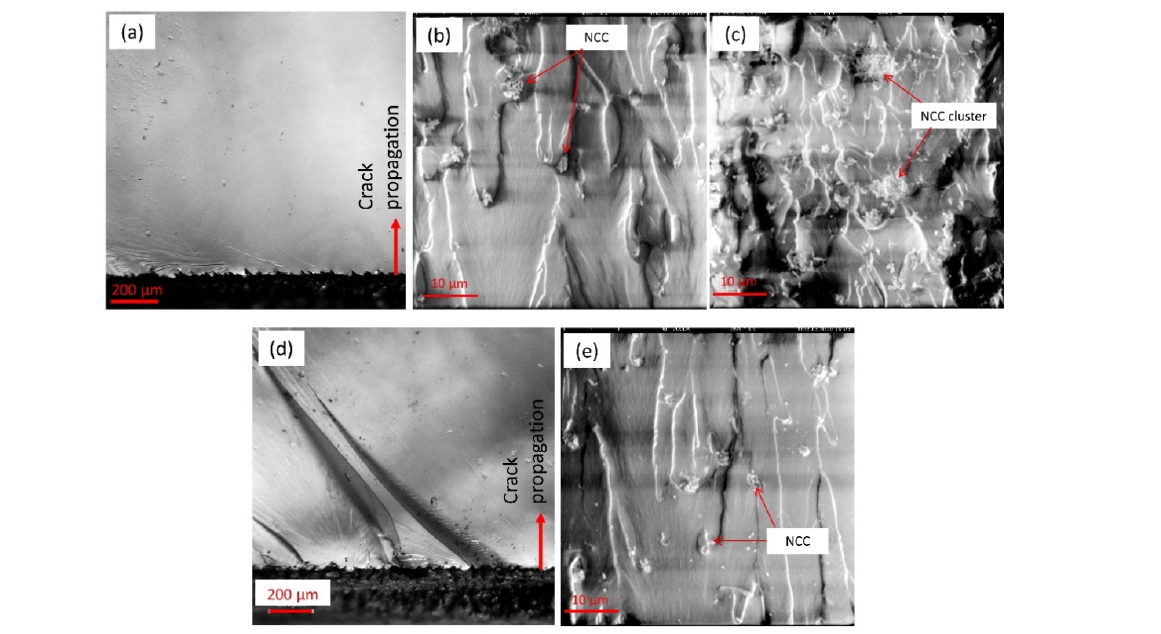
Fig. 6. The SEM micrographs of the surfaces of broken impact specimens (a) neat unaged UPR, (b) unaged 1 wt% NCC, (c) unaged 5 wt% NCC, (d) aged neat UPR, (e) aged 1 wt%